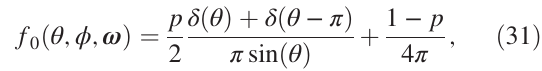
uniformly spread on S ) and after T ¼ 1 . 25 × 10 5 time units (in red). Note how i